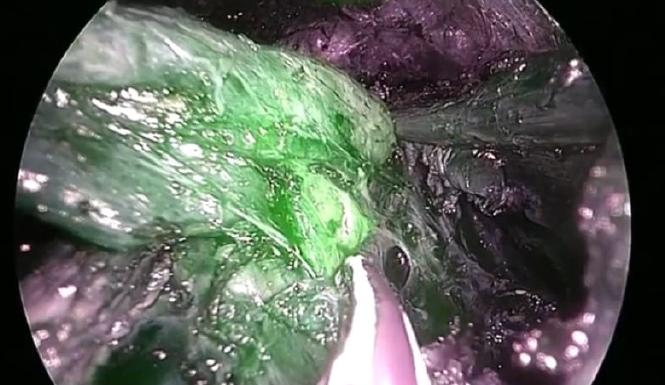
Figure 2. The use of indocyanin green fluorescence imaging for the intraoperative identification of the parathyroid glands during the transoral vestibular thyroidectomy.